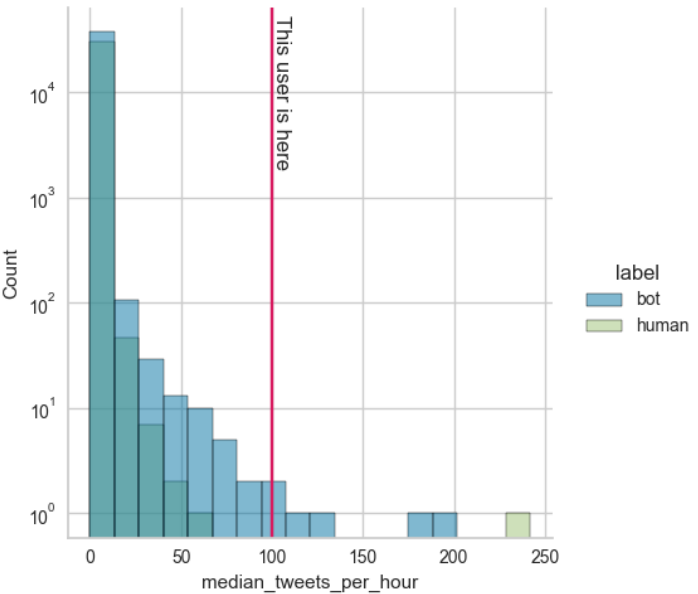
Figure 11. Visual explanation of where the explored user resides, with respect to the total training data. The red line points out where the user under investigation